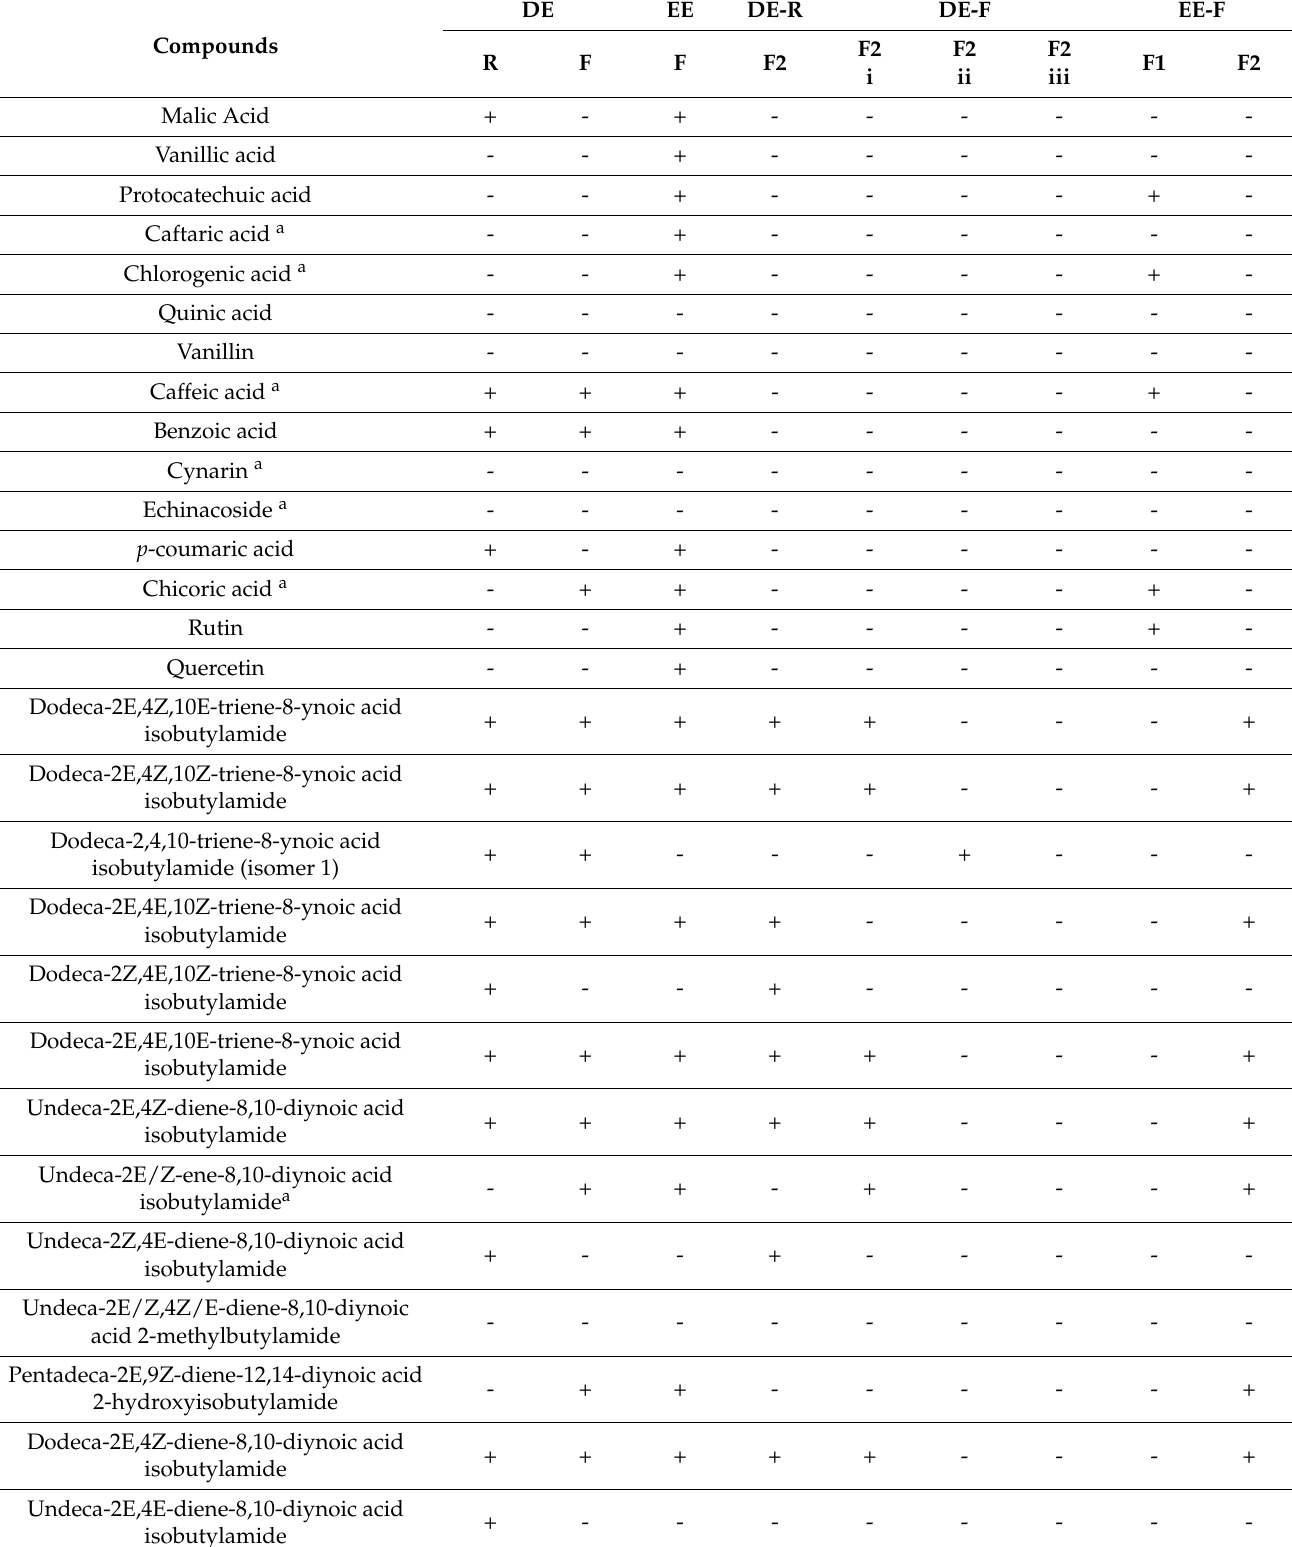
Table 2. Overview of the identified compounds (phenols/carboxylic acids and alkylamides) in E. purpurea extracts and fractions by